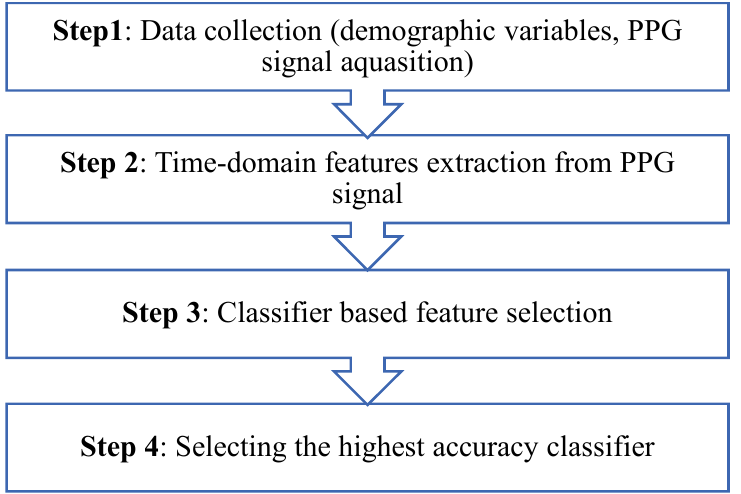
Figure 5. Schematic diagram of the proposed classification algorithm.